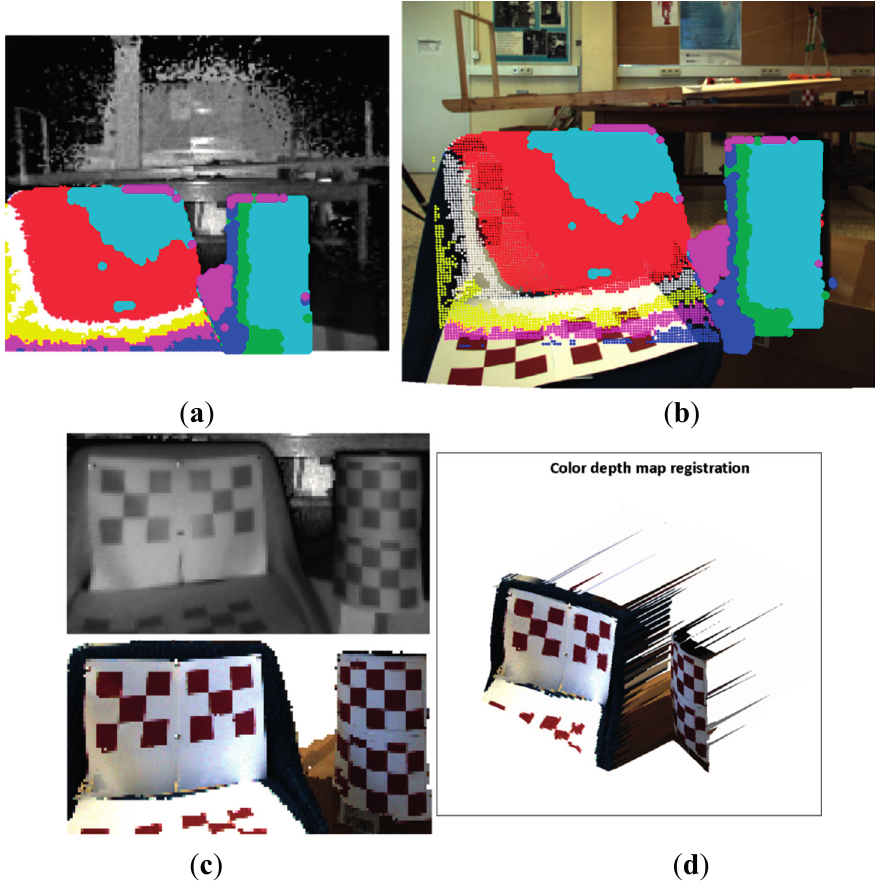
Figure 13. Image sample 22. ( a ) Selected points on the ToF; ( b ) estimated points on the RGB image; ( c ) Top: selected ToF ROI. Bottom: estimated RGB ROI; ( d ) the colour depth map of the